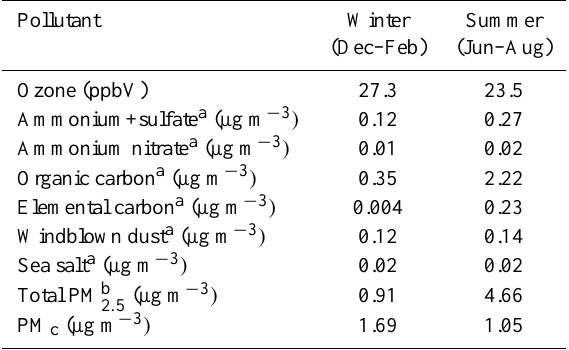
Table 8. Average simulated winter and summer natural pollutant levels for the modeling